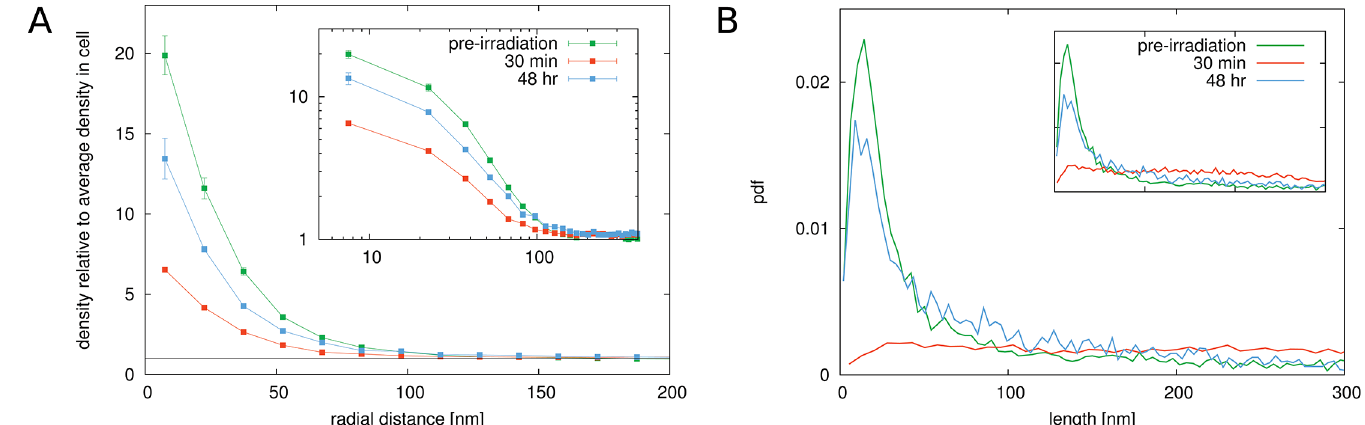
Fig 7. Results for cells exposed to 0.5 Gy radiation. Panel A. The figure shows the radial radial distribution function for H4K20 antibodies representing heterochromatin (methylated histone variants) for non-irradiated and irradiated cells. Error bars represent the standard deviation of the mean value after averaging over the sample of cells. The value for g ( r ) at small distances goes up to around 20, indicating the high marker densities in regions where heterochromatin is located. The rapid drop off of the radial distribution function within a distance of less than 100 nm shows that heterochromatin forms small clustered areas that are spread throughout the cell nucleus. Upon exposure to 0.5 Gy γ -irradiation, a dramatic change in the correlation function can be observed in cells that were imaged after 30 min. The value at small radial distances drops to around 6, or around 70% smaller than in non-irradiated cells. This indicates that the density in the heterochromatic regions becomes on average much lower in irradiated cells. In cells measured 48 h after irradiation, the correlation function have recovered again and the value at small r is at around 14, only 30% less than in unirradiated cells. Panel B. The distribution of edge lengths in the Delaunay triangulation of the markers confirms these observations. A sharp peak in the distribution at around 30 nm can be seen in untreated cells. In 30 min post-irradiation cells the peak vanishes and a spread distribution can be seen. In 48 h post-irradiation cells however, the peak reappears again but less pronounced than in untreated